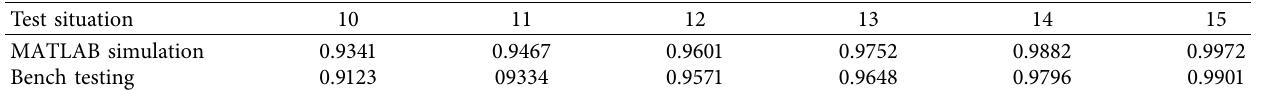
Figure 22: Display of wireless temperature sensor values at specific locations on the second level of the table. Table 3: Comparison of simulation and actual bench test